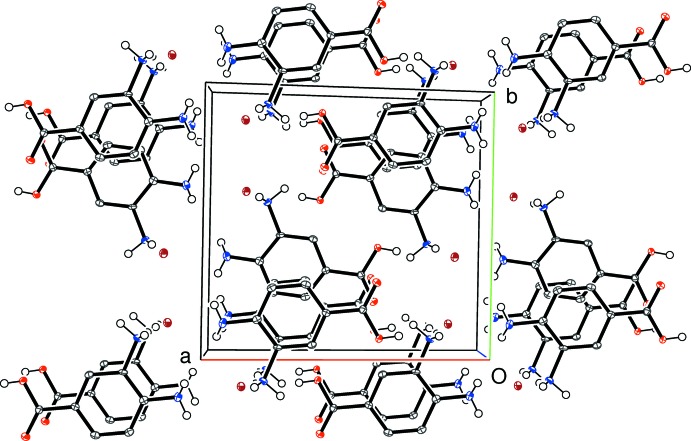
The packing for (II) viewed down [001].